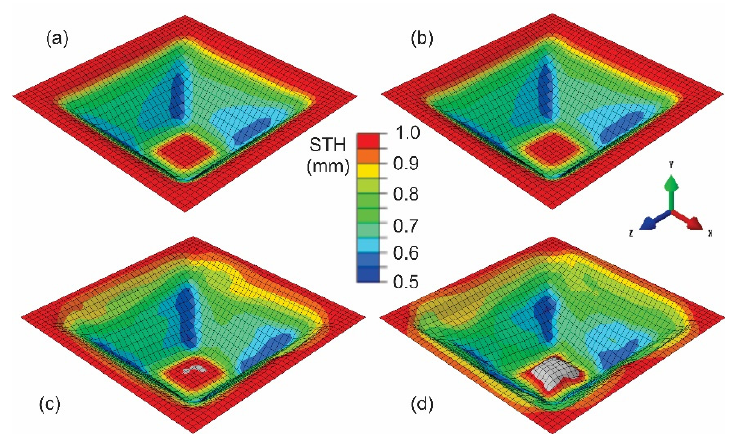
Figure 8. Part thickness at different mass scaling factors of the SPIF process at a punch speed of 40 m/s and element size of 3 × 3 mm—( a ) mass scale 1, ( b ) mass scale 10, ( c ) mass scale 30, and ( d ) mass scale 50.